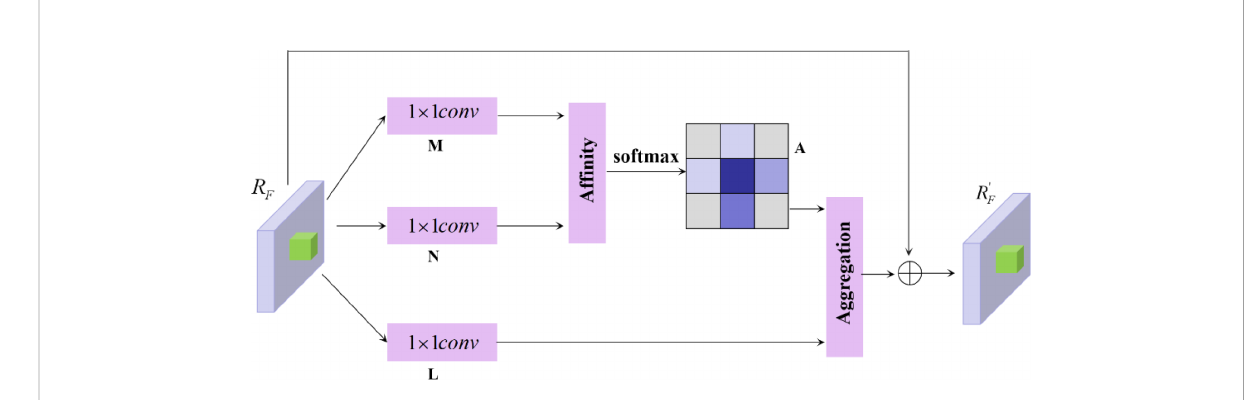
FIGURE 5 CCA module ( R F feature maps are processed by the CCA module to highlight tabular